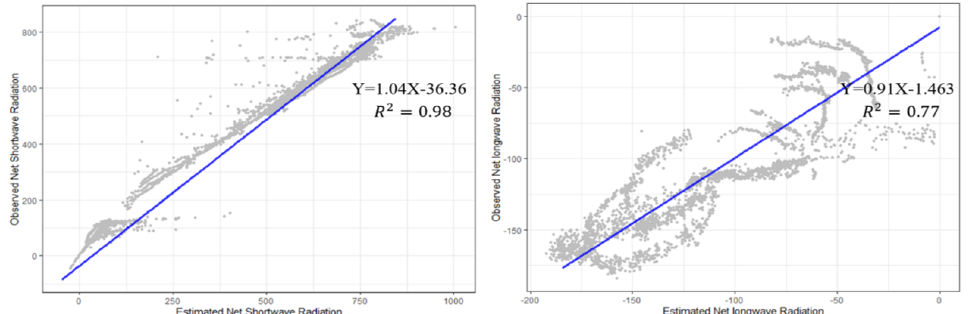
Figure 5. Validation of Shortwave radiation R 2 = 0.98 and Longwave radiation R 2 = 0.77.